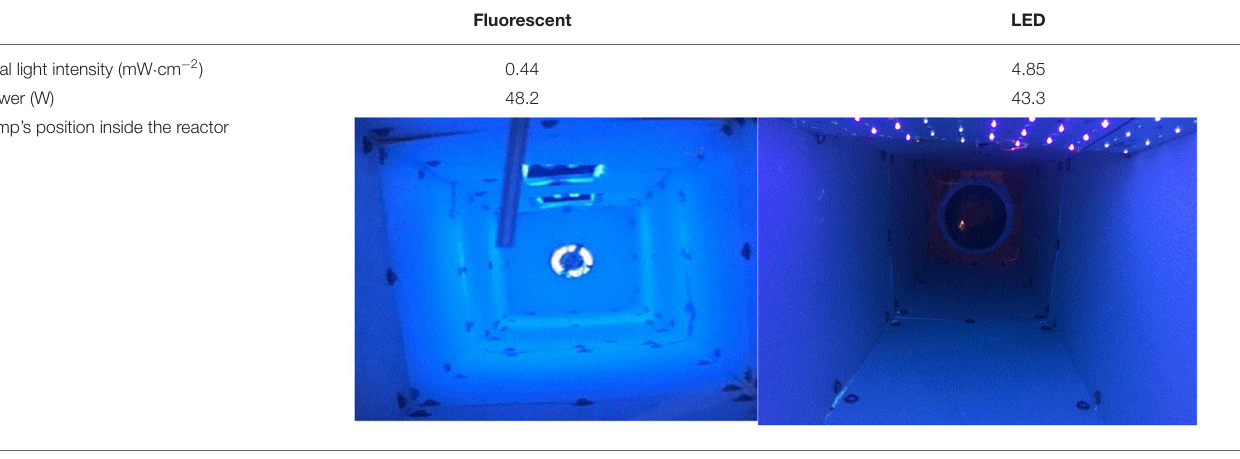
Frontiers in Chemistry |